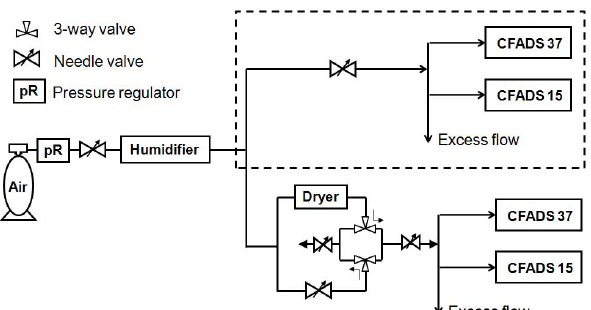
Fig. 1. Schematic of the setup for experiments to derive water va- por correction functions (experiments were done separately to the two CRDS analyzers, i.e. CFADS 37 and CFADS 15 although they could be tested at one time) and correlate water vapor measurements of two individual CRDS analyzers (see inside the dashed lines).